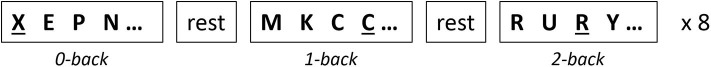
Illustration of the N-back working memory task. In the 0-back condition, the target letter is “X” (indicated with underline). In the 1- and 2-back conditions, the target letter is the same as the letter from 1- or 2-steps before in a given sequence, respectively. Each condition was repeated eight times with the rest period in between conditions.